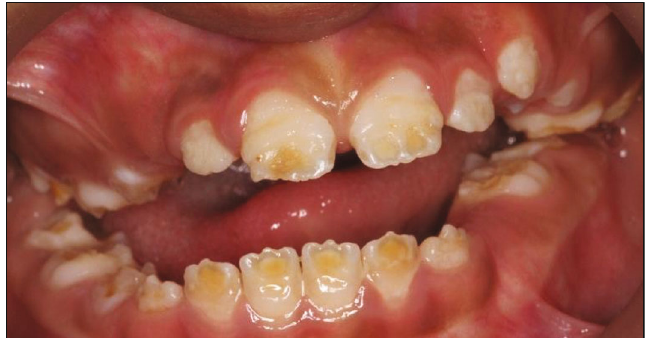
Figure 1: Frontal view with teeth in occlusion.